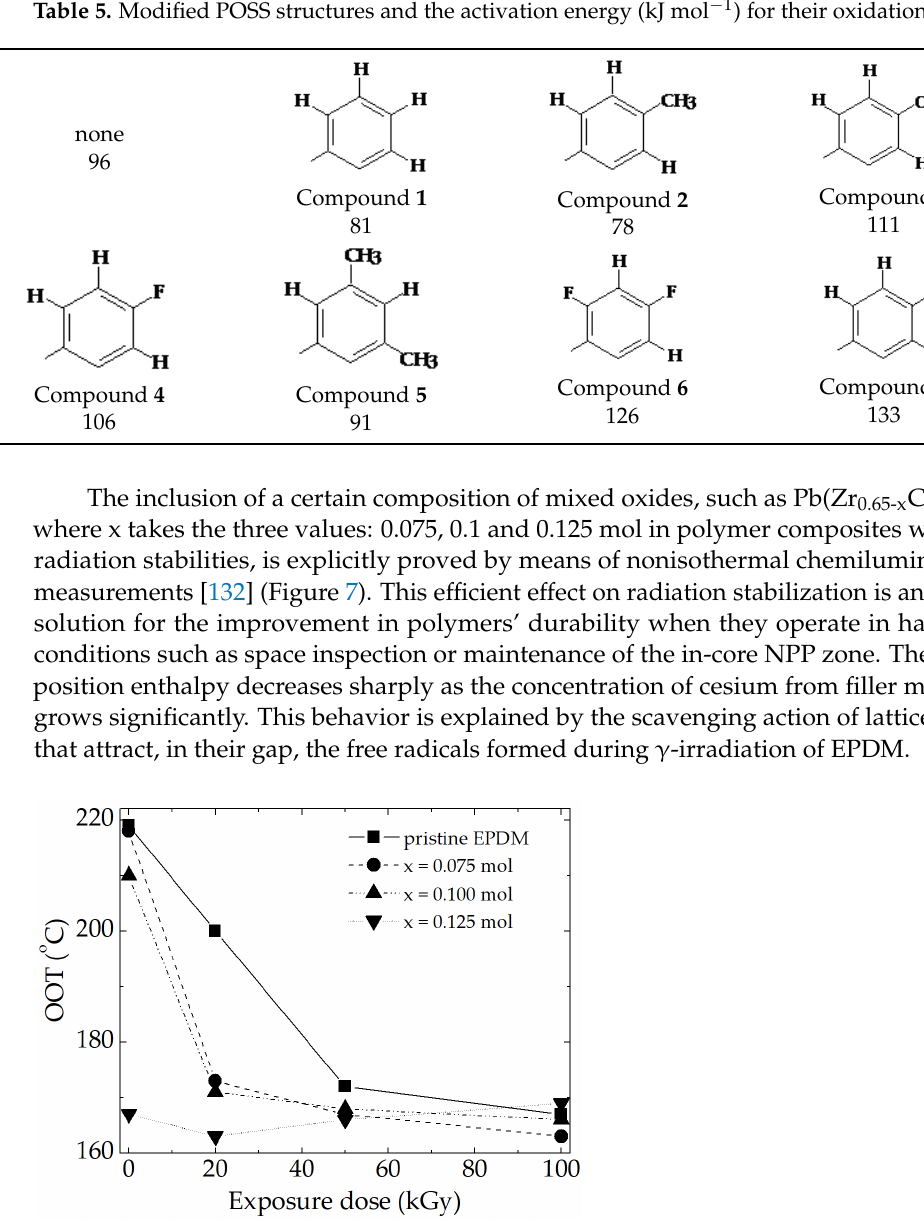
Figure 7. Modification in OOT values for the radiation oxidation of EPDM modifies with Pb(Zr 0.65-x Ce x Ti 0.35 ) [132] .